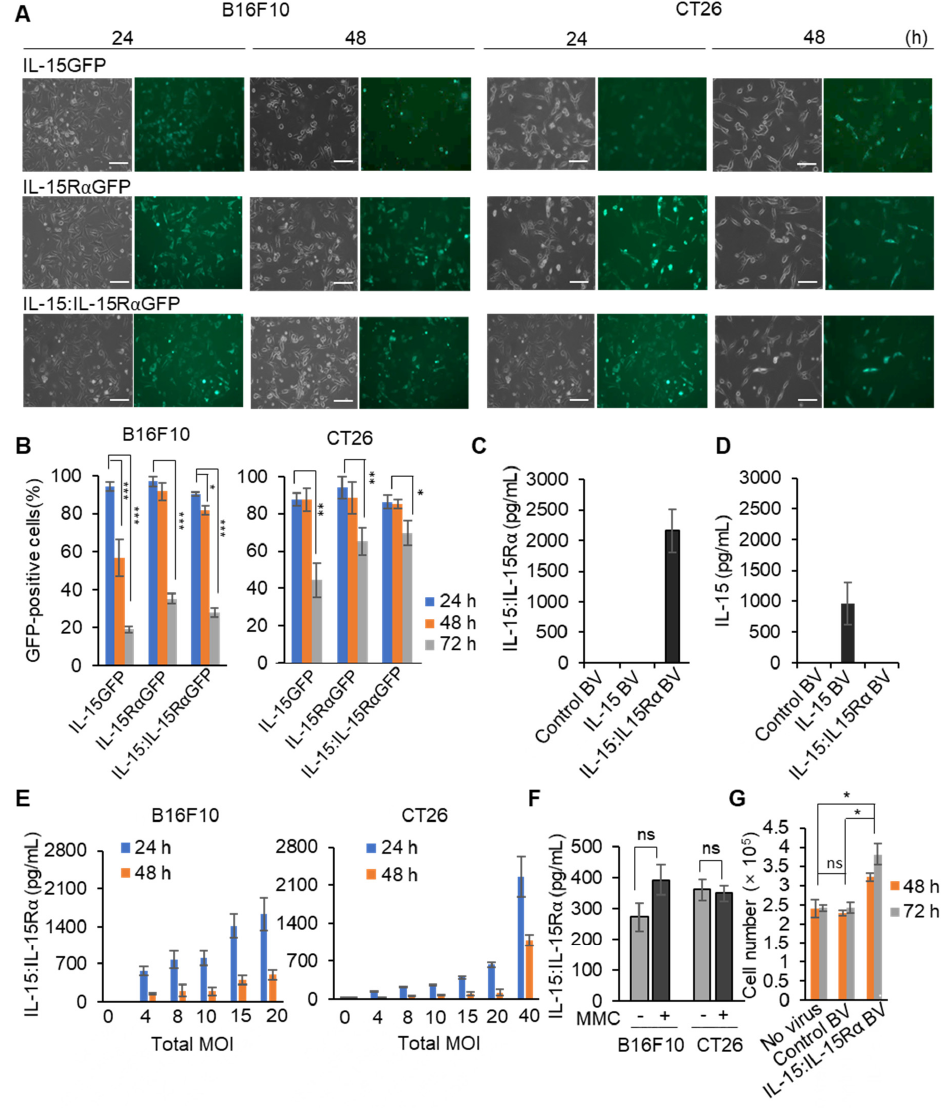
Figure 2. Transduction efficiency in murine cancer cells following infection with BV. ( A , B ) B16F10 melanoma or CT26 colon cancer cells were infected with either IL-15GFP BV or IL-15R α GFP BV or both IL-15 BV and IL-15R α GFP BV at the total MOI of 40 and then incubated with a complete medium including sodium butyrate. After 24 h, cells were washed (24-h sample), replaced with a fresh medium without sodium butyrate. After another 24 h and 48 h, the cells were monitored (48-h and 72-h samples, respectively). GFP expression was analyzed under a Nikon fluorescence microscope (scale bar: 100 µ m). Left and right figures show the total and GFP-positive cells, respectively ( A ). The infection ratio was estimated by the percentage of GFP-positive cells per the total number of cells. The number of GFP-positive cells was counted using the ImageJ software ( B ). ( C , D ) Control BV, IL-15 BV, or the mixture of IL-15 BV and IL-15R α BV were used to infect 5 × 10 5 B16F10 cells; 24 h after the viral infection, the concentration of IL-15 or IL-15:IL-15R α in culture supernatants was quantitated by an IL-15:IL-15R α complex-specific ( C ) or IL-15-specific ( D ) ELISA kit. ( E ) Cancer cells (3 × 10 5 ) were infected with BV at the indicated total MOI (0, 4, 8, 10, 15, 20, 40) in six-well plates. After 24 h, culture supernatants were harvested, replaced using a complete medium, and incubated for an additional 24 h (48-h sample). ( F ) After the 24-h BV infection, the B16F10 or CT26 cells were treated with or without MMC (50 µ g/mL) for 1 h and incubated with a complete medium for additional 24 h. The IL-15:IL15R α expression in the final supernatant was analyzed with an ELISA. ( G ) Naïve mouse splenocytes were treated with culture supernatants from control BV- or IL-15 BV + IL-15R α BV-infected B16F10 cells for 48 or 72 h. The supernatant from non-infected cells was used as another control (no virus). Cell numbers of the proliferating splenocytes were counted and graphed. Note: * p < 0.05, ** p < 0.01, *** p <